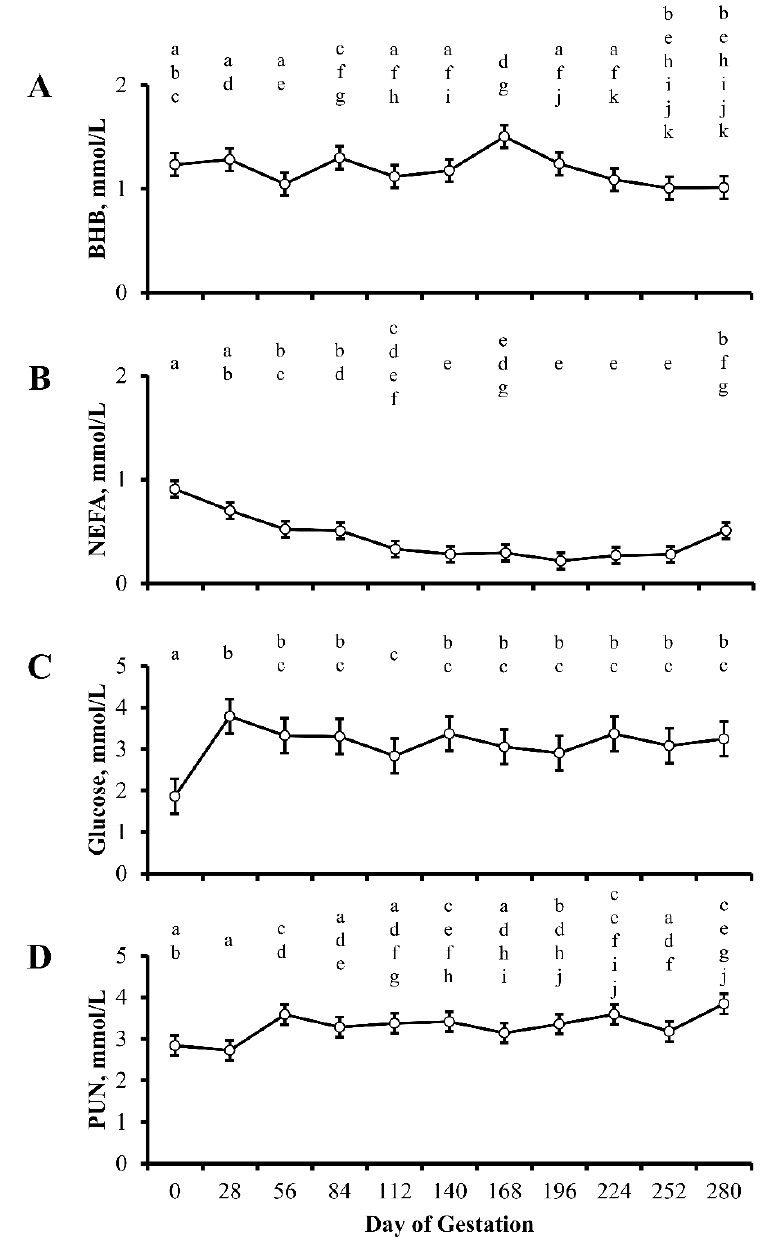
Figure 1. Least squares means ± SEM (mmol/L) of beta-hydroxybutyrate (BHB; A ), NEFA ( B ), glucose ( C ), and plasma urea nitrogen (PUN; D ) in multiparous cows by day of gestation. Dietary treatments were: Control (0 g urea/animal/day) or Urea (80 g urea/animal/day). Treatments were offered from day 28 of gestation to parturition. Concentrations of BHB, NEFA, glucose, and PUN did not differ by treatment ( p ≥ 0.06) or treatment by day interaction ( p ≥ 0.08), but were influenced by day of gestation ( p ≤ 0.04) a–k Days with different lower case letters are different ( p ≤ 0.05).